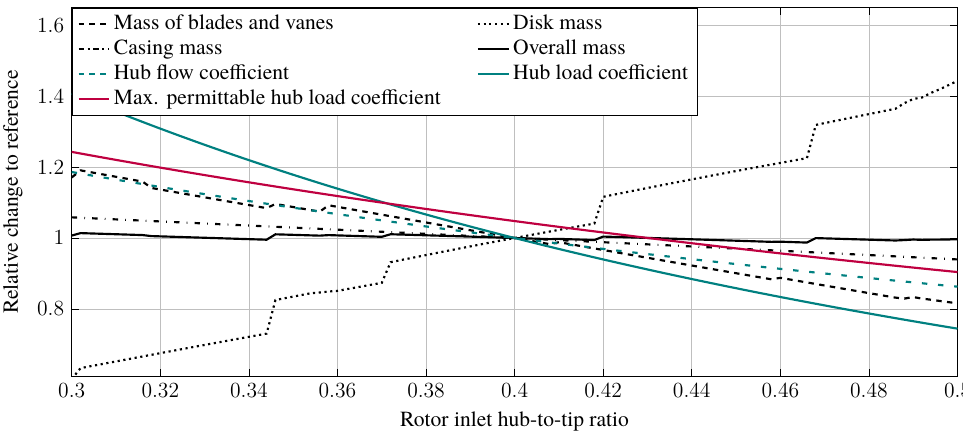
Figure 14. Relative changes in masses and aerodynamic parameters over the hub-to-tip ratio for the reference fan